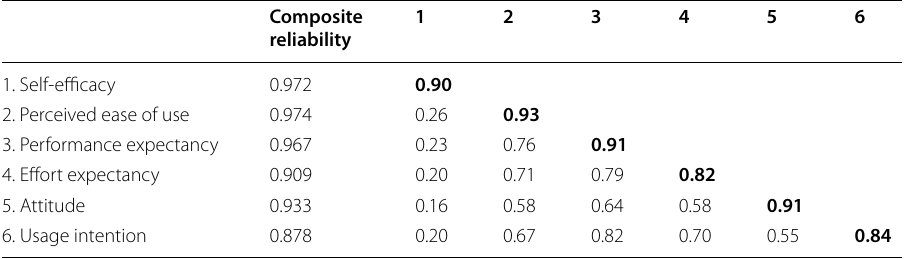
Square root of AVEs reported along diagonal in bold